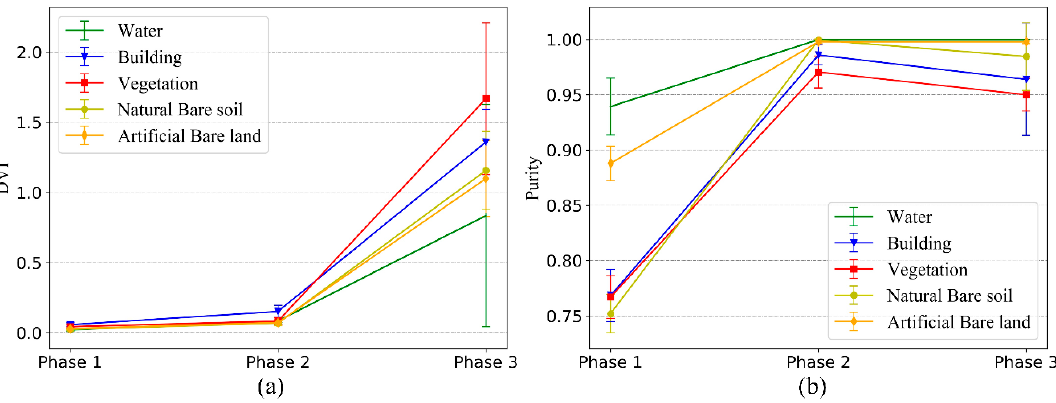
Figure 11. The mean and standard deviation curves of each phase. (a) The DVI of each phase. (b) The purity of each phase.